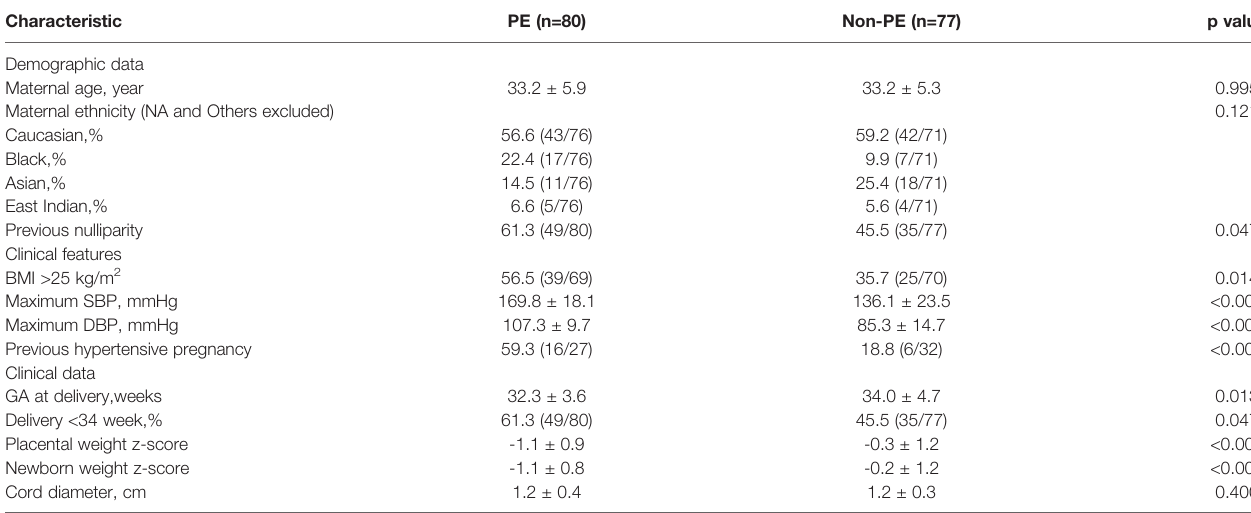
TABLE 1 | Clinical Differences between the preeclampsia and non-preeclampsia groups.